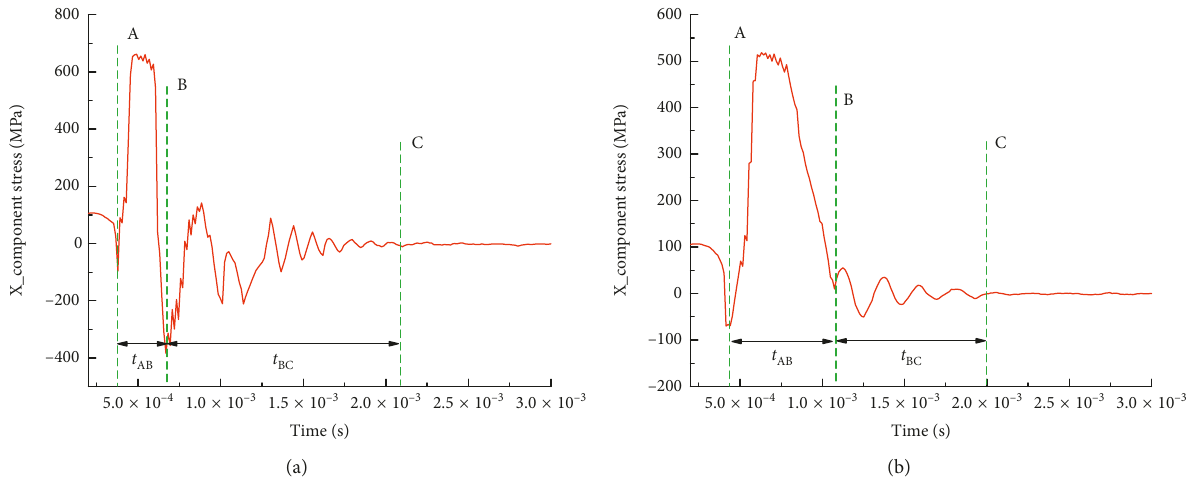
Figure 24: Comparison of the radial stress on the root of blade in different Young’s modulus. (a) Initial Young’s modulus. (b) 50% Young’s modulus.